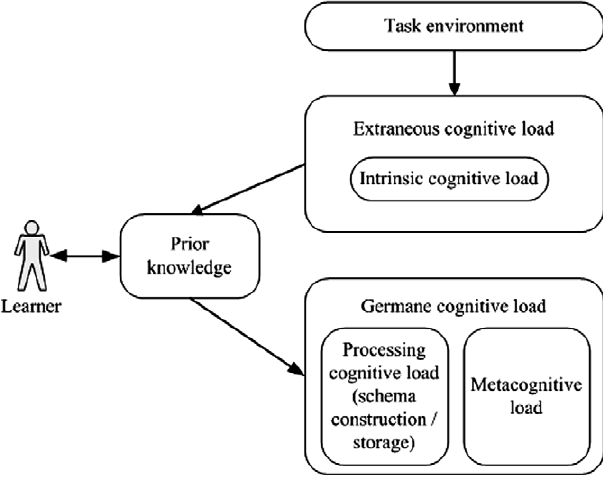
Figure 1. Valcke ’ s (2002) updated model for cognitive load theory.